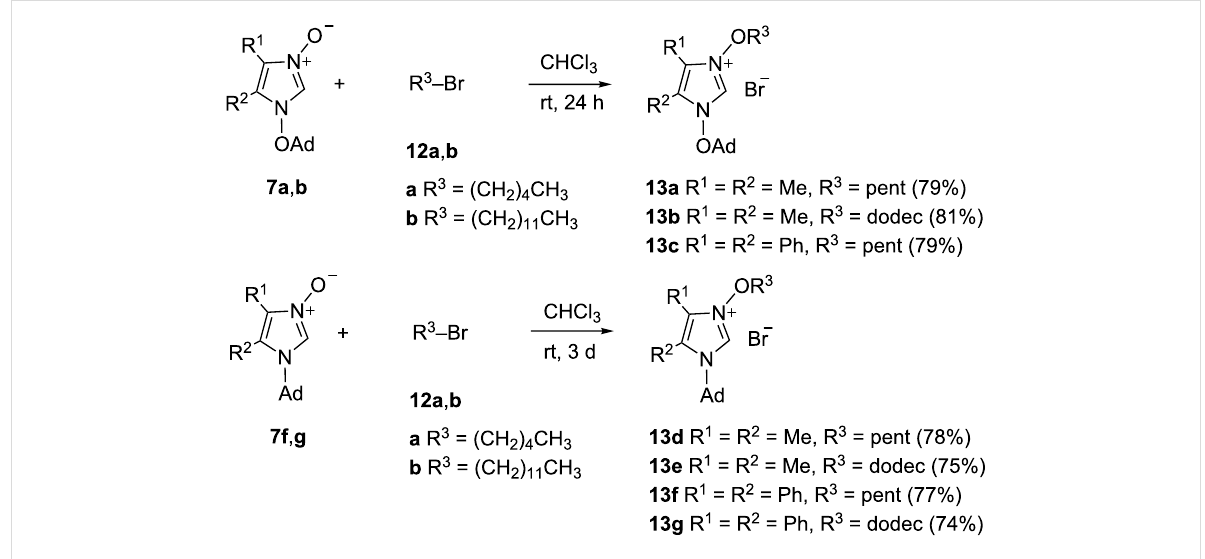
substituent enhances the nucleophilicity of the N -oxides and